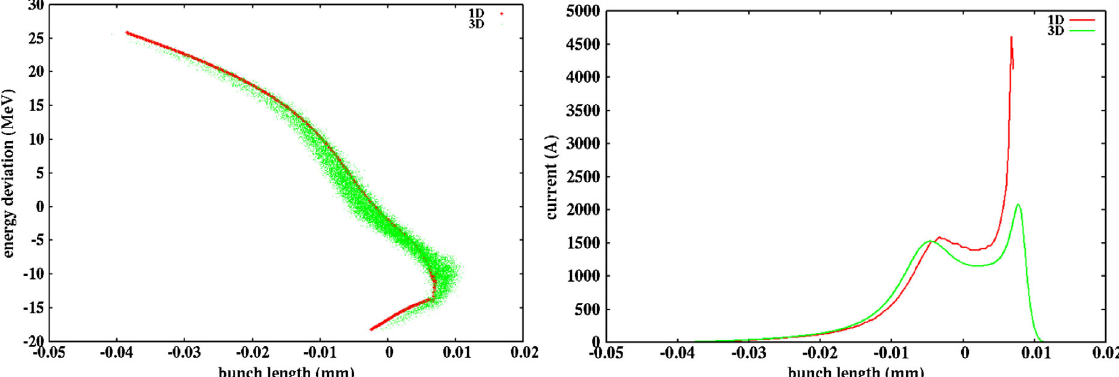
settings.FIG. 8. Longitudinal phase space distribution (left) and current profile (right) after BC2 of the linac from the 1D model (red) and from the 3D model (green) using an optimal solution